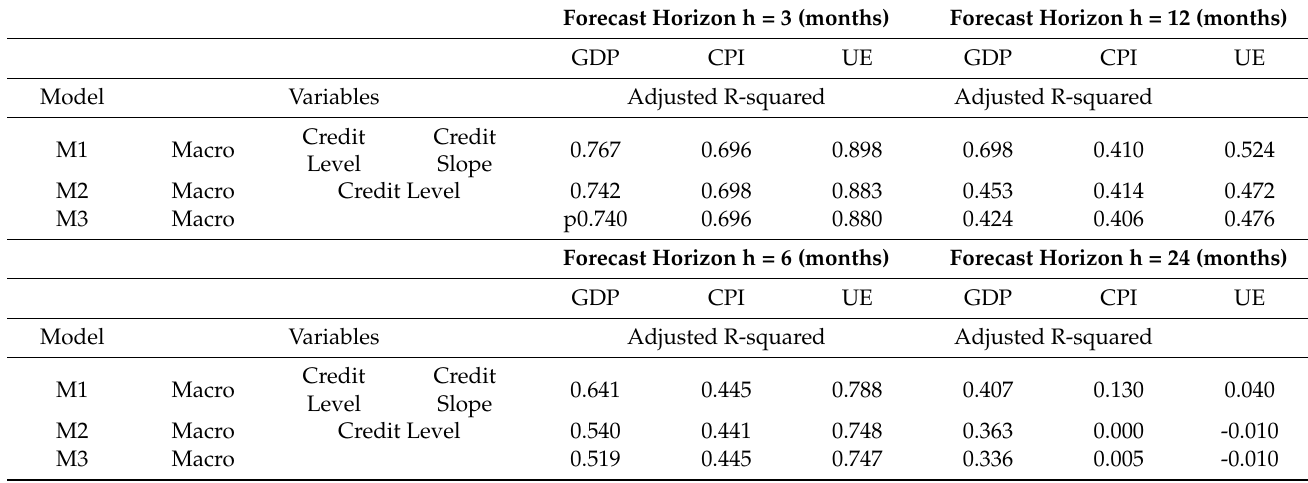
Table 2. In-sample predictive content of credit spreads for economic